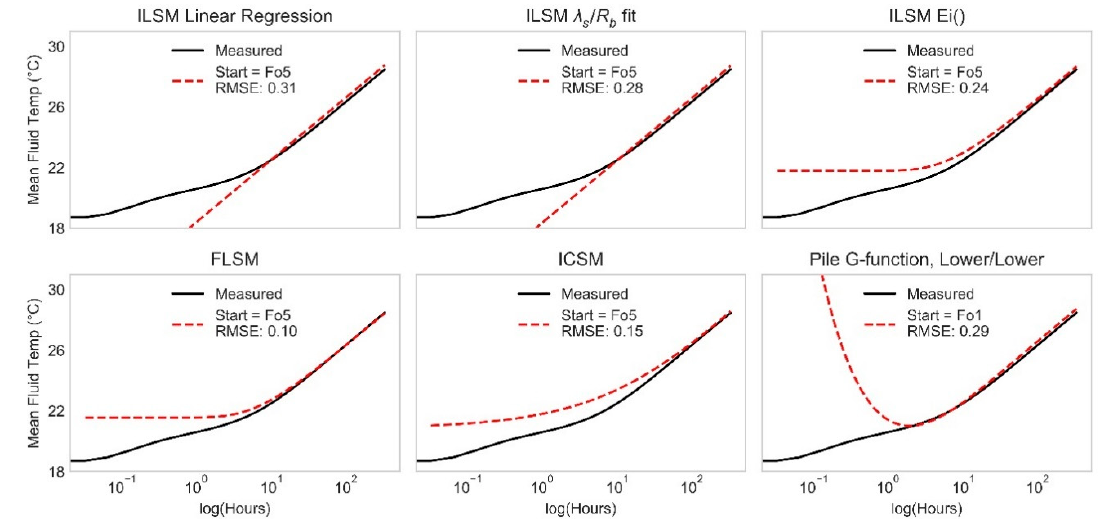
Figure 13. Visual fit of each model with best fit thermal parameters based on results in Figure 11, with fitting region and RMSE shown. FLSM: Finite Line Source Model; ICSM: Infinite Cylindrical Source Model.